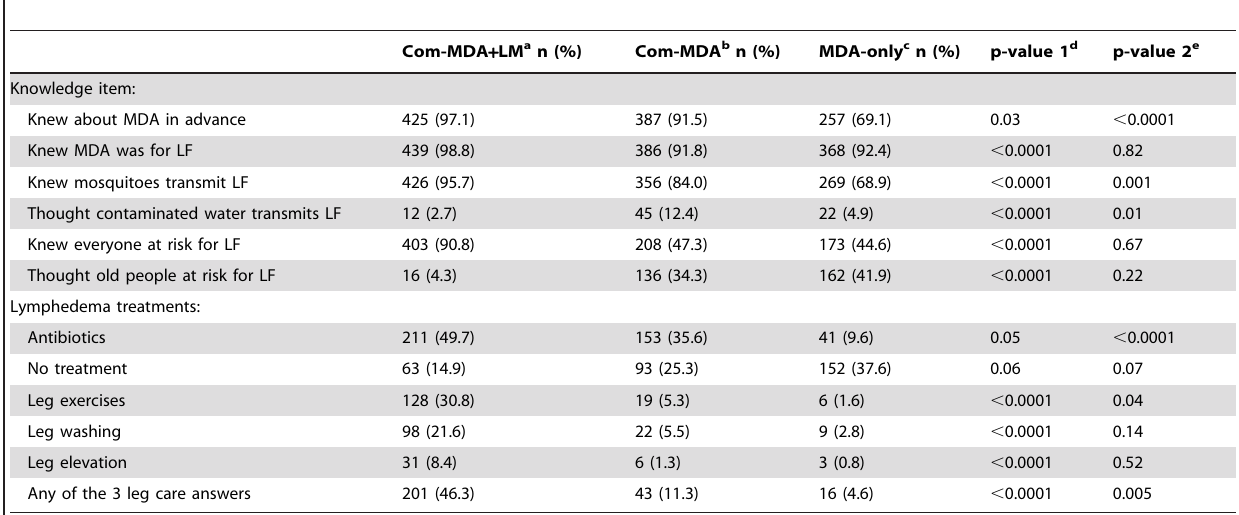
Table 3. Com-MDA + LM participants had greater knowledge than Com-MDA participants that LF is transmitted by mosqui- toes, everyone is at risk for LF, and there are specific treatments for lymphedema such as leg exercises, leg washing, and leg elevation. Com-MDA participants were much more likely than Table 3. Knowledge about LF and MDA among KAP survey participants from the 2008 MDA, Khurda District, Orissa